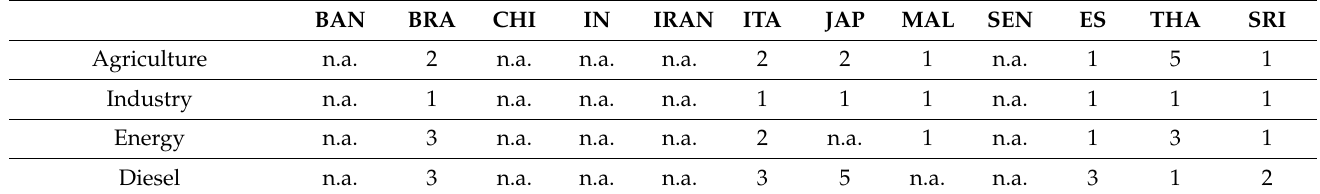
Table 4. Health and safety: risk for workers to be affected by fatal accidents (in cells the score, 1 = very low risk, 5 = very high risk, n.a. = not available) [69].